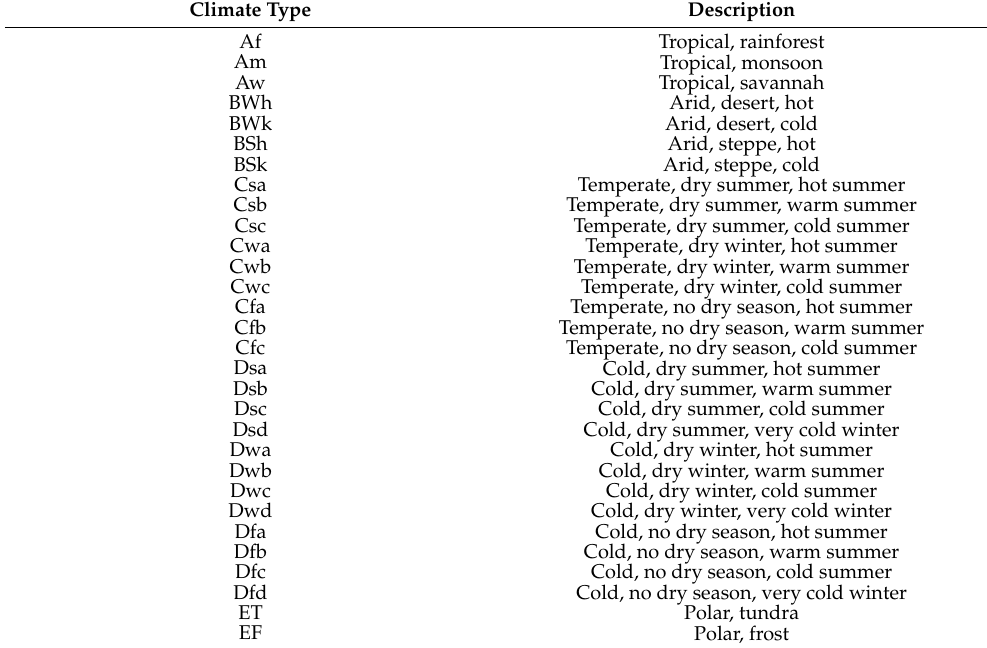
Table A1. The description of the Köppen-Geiger classes